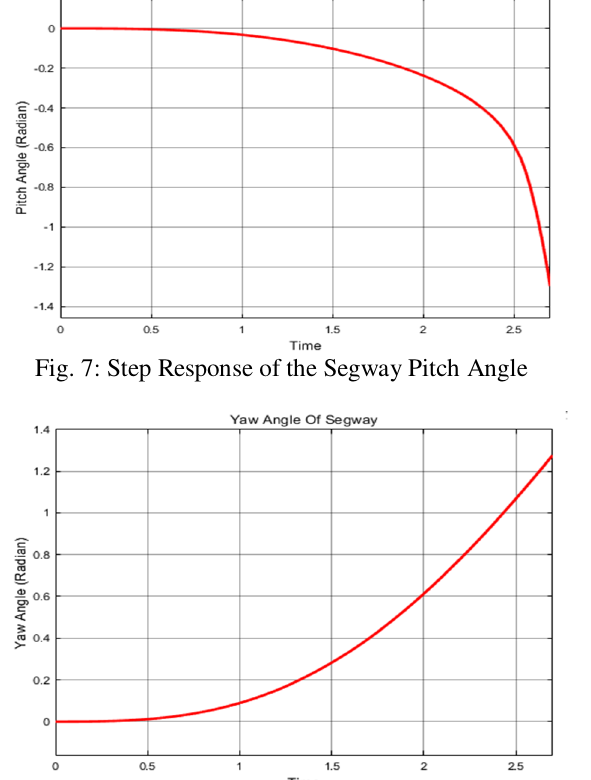
Fig. 8: Step Response of the Segway Yaw Angle